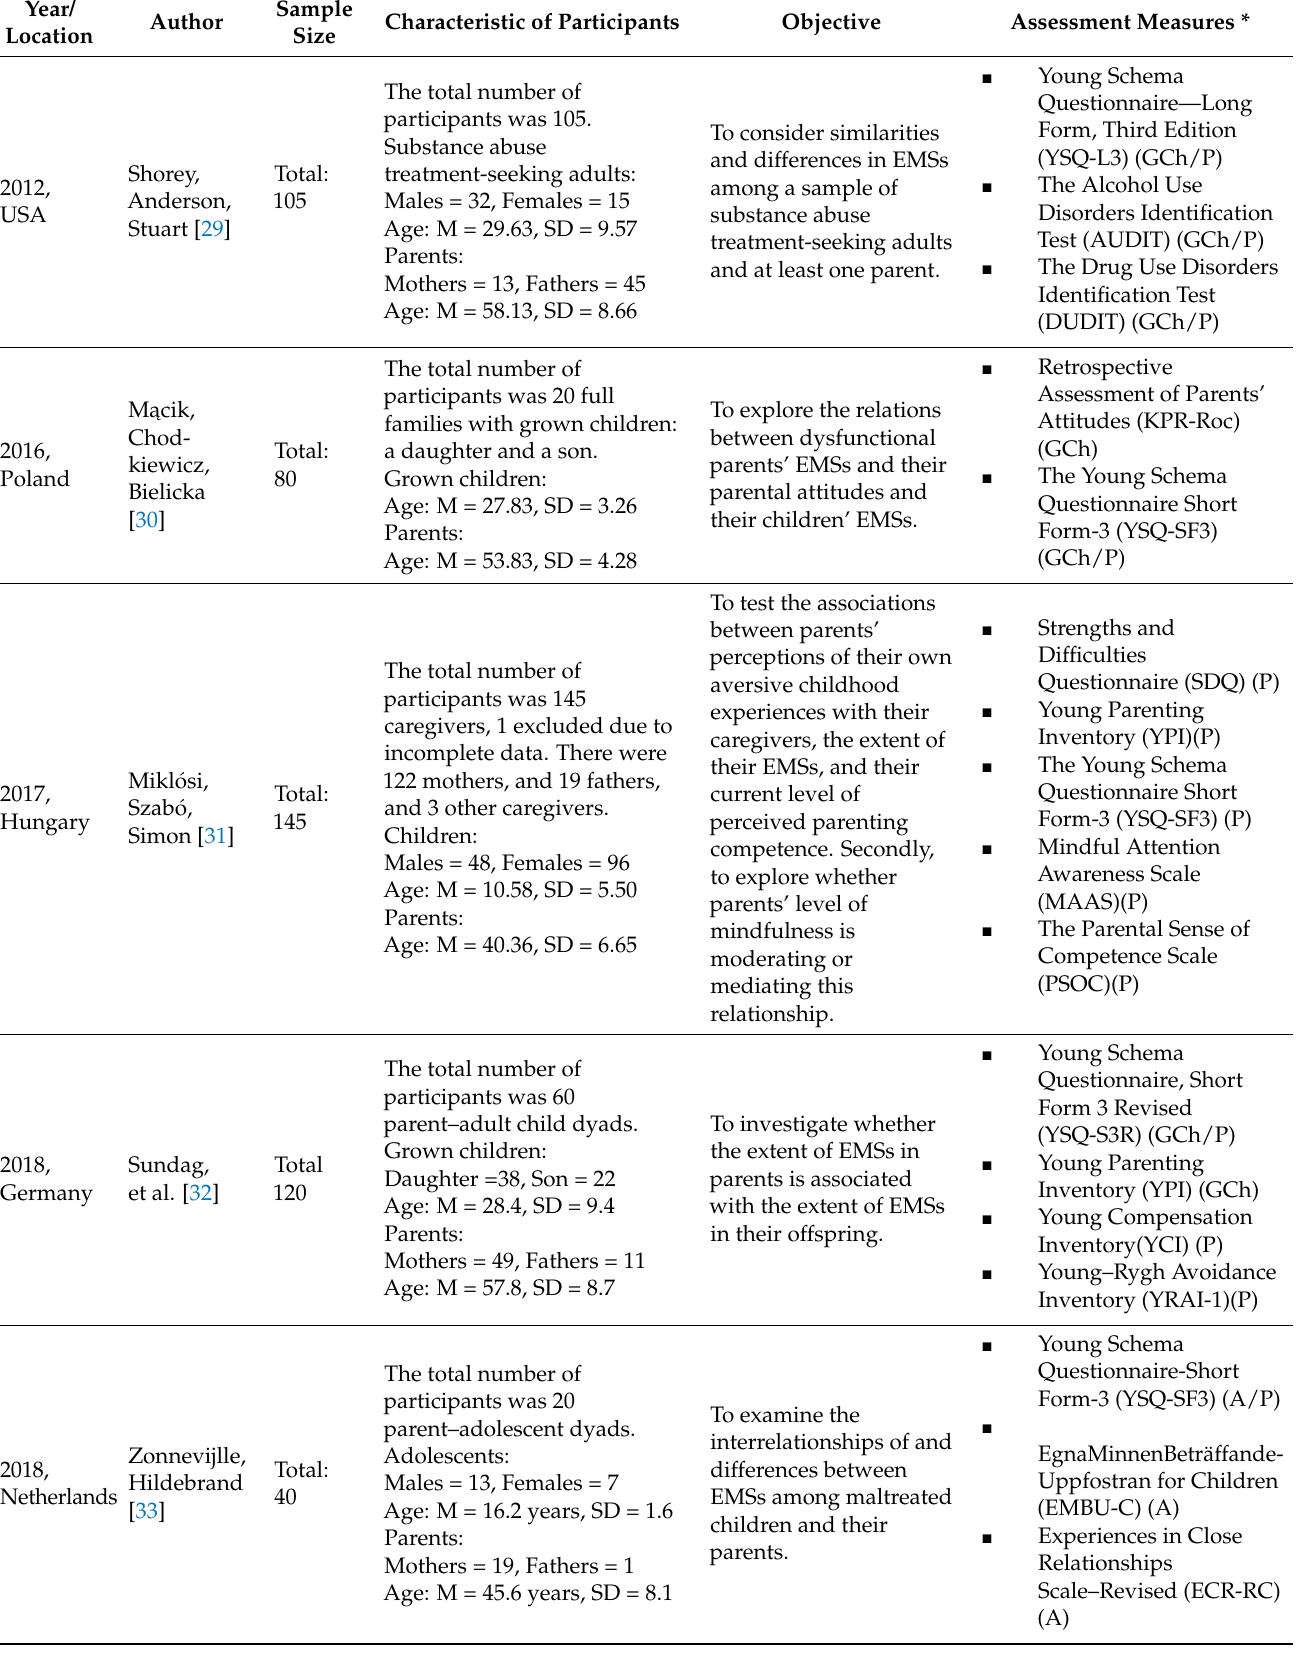
Table 2. Characteristics of the